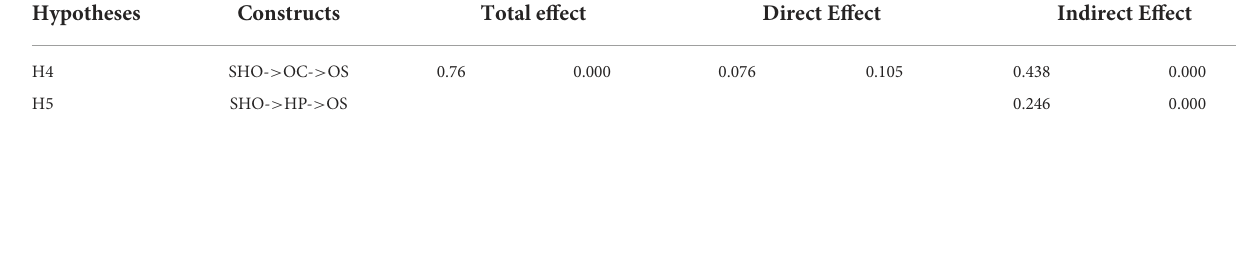
TABLE 8 Mediation